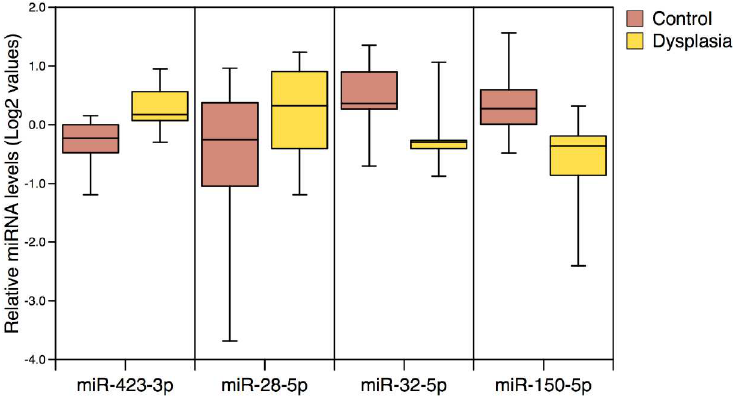
Fig 4. Serum miRNA levels in UC dysplasia and UC controls. Serum levels of miRNAs with a fold change > 1.5 in UC patients with dysplasiacomparedto UC controls are shown. Data are presented as a box and whiskersplot. Differencesin the levels of these miRNAs in serum did not reach the statistical significance threshold. https://doi.org/10.1371/journal.pone.0173664.g004 PLOS ONE | https://doi.org/10.1371/journal.pone.0173664 March 13,